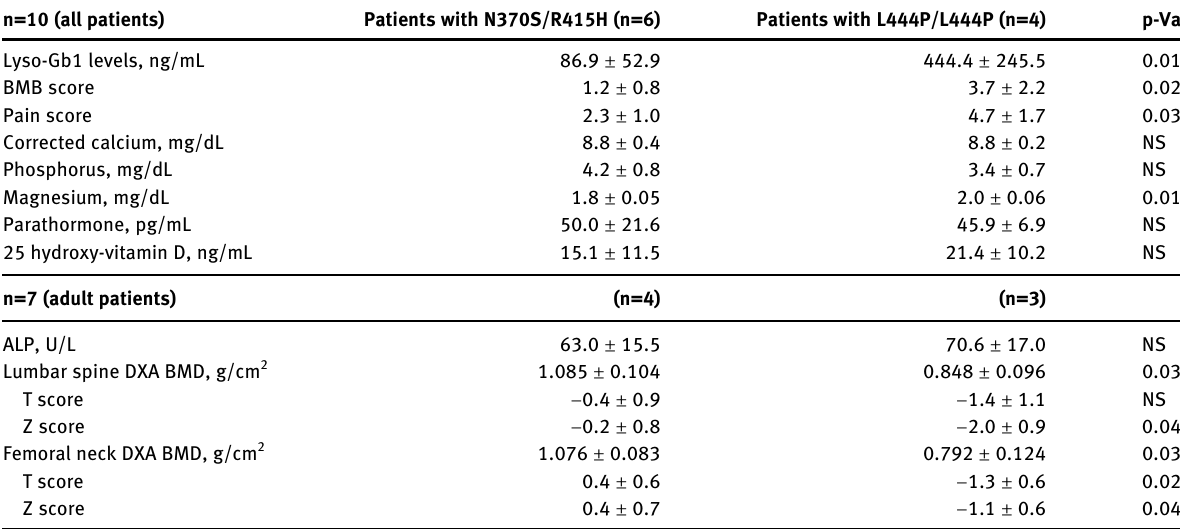
Table  : Comparison of the features of the patients according to the type of genetic mutation. n=  (all